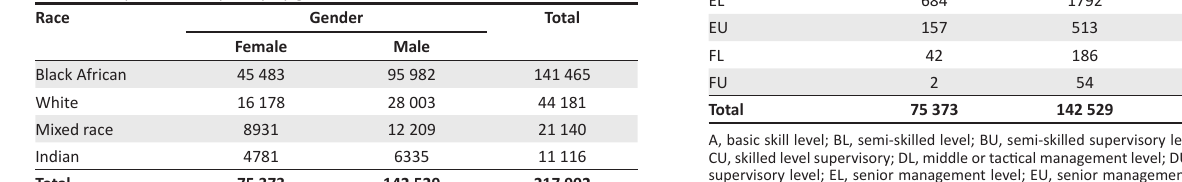
TABLE 1: Population frequency by gender and race.